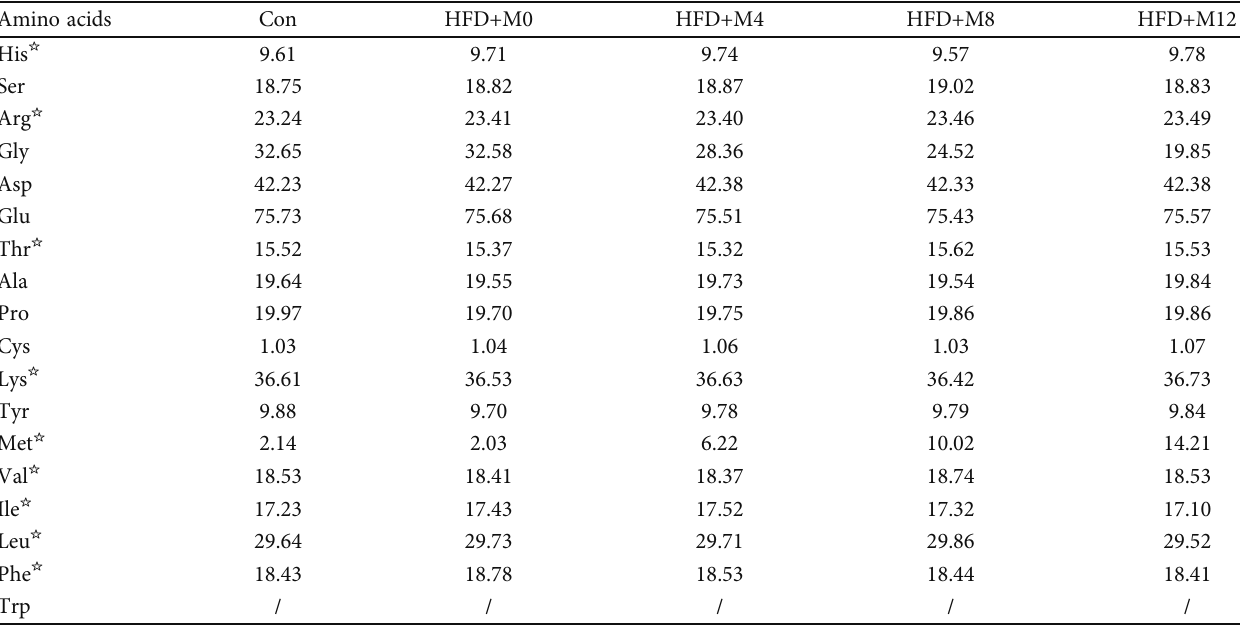
Table 2: Contents of amino acids of experimental diets